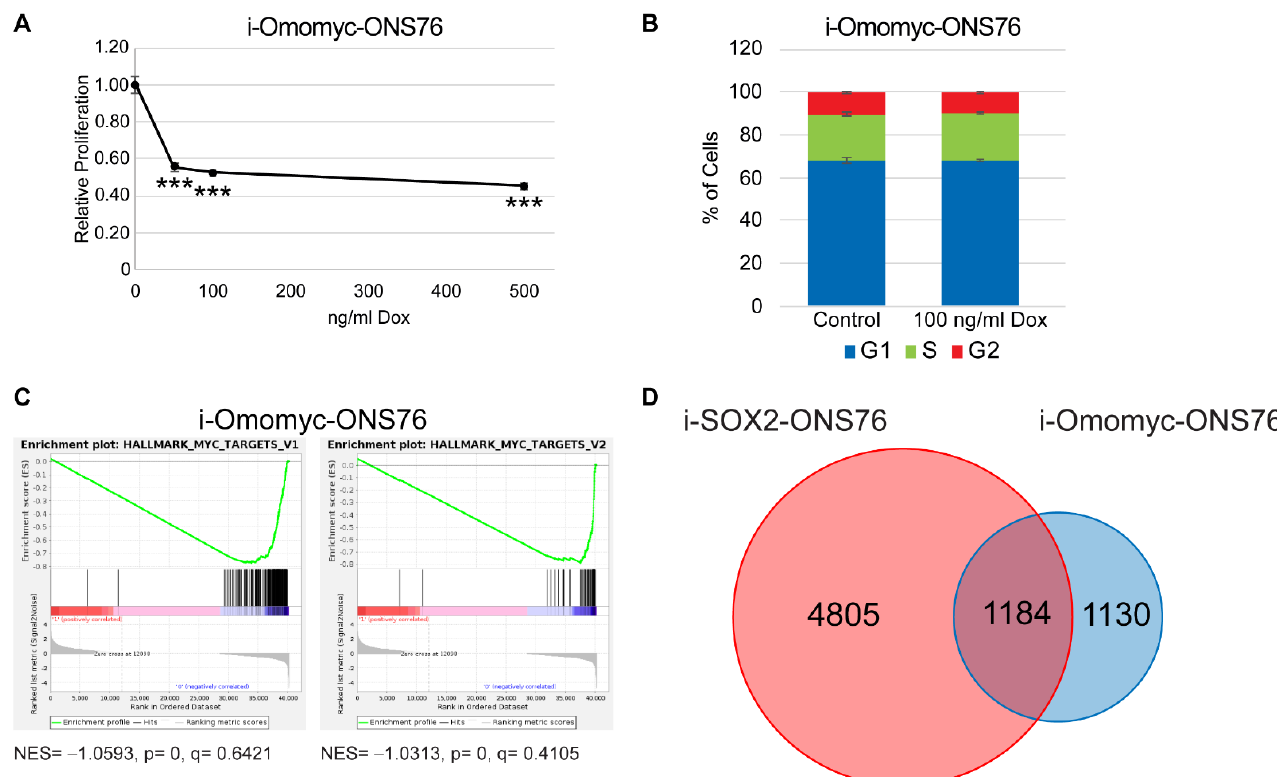
Figure 4. Omomyc induction recapitulates the proliferative and cell cycle effects of elevated SOX2. ( A ) Proliferation of i-Omomyc-ONS76 cells as determined by MTT assay following 4 days of culture in the presence of Dox at the indicated doses. ( B ) Cell cycle analysis of i-Omomyc-ONS76 cells was performed by flow cytometry after 4 days of culture in the presence or absence of 100 ng/mL Dox. ( C ) Gene set enrichment plots for MYC target genes in i-Omomyc-ONS76 cells. ( D ) Venn diagram comparing i-SOX2-ONS76 DEGs and i-Omomyc-ONS76 DEGs. Error bars represent the standard deviation. *** p < 0.001.